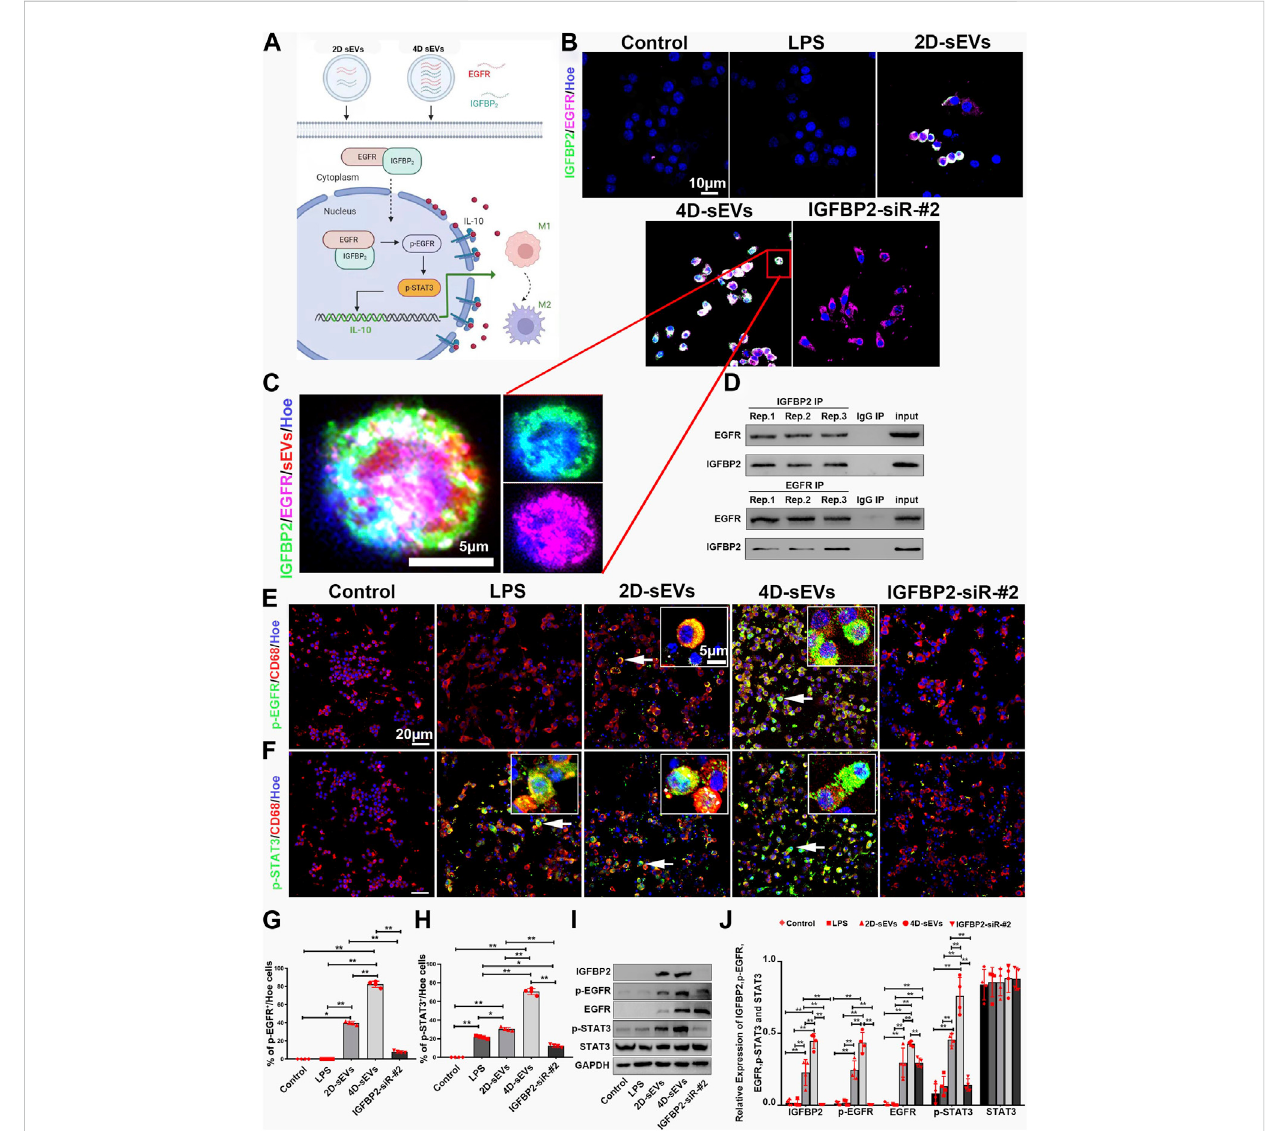
FIGURE 6 The IGFBP2/EGFR protein transported within sEVs activates the STAT3 pathway in RAW264.7 cells in vitro . (A) Diagram showing how sEVs- transportedIGFBP2/EGFRproteinpromotesM1toM2polarizationofmacrophages. (B) Fluorescentlystainedimagesshowingco-labeledIGFBP2(green) and EGFR (purple) in RAW264.7 cells within each group. (C) The high magni fi cation of B in the frame. (D) Co-immunoprecipitation (IP) of IGFBP2 and EGFR in RAW264.7 cells. (E) Fluorescently stained images showing p-EGFR + /CD68 + cells in each group. (F) Fluorescently stained images showing p-STAT3 + /CD68 + cells in each group. (G, H) : Bar charts showing p-EGFR and p-STAT3 activation rate. (I) Western blot analysis of protein expression (IGFBP2, p-EGFR, EGFR, p-STAT3, STAT3). (J) Quantitative analysis of Western blot. Statistic difference: * p < 0.05; ** p <